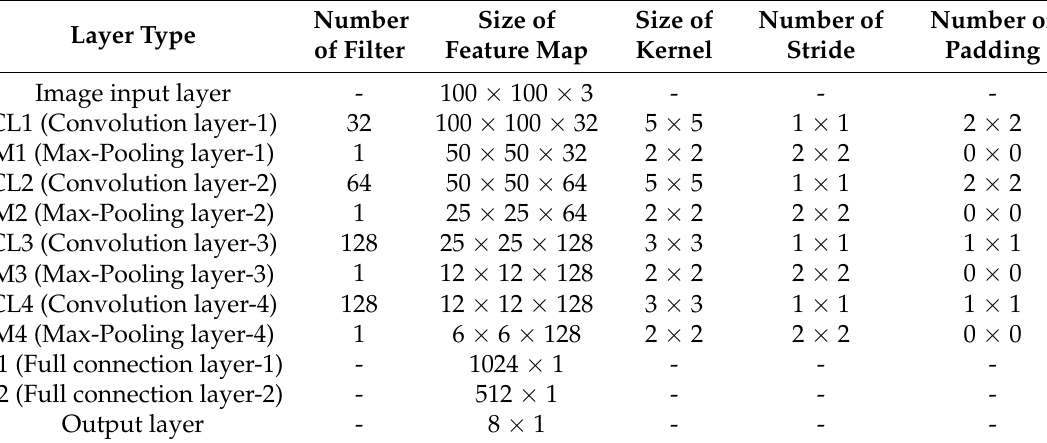
Figure 7. Thermal images under eight gears with different health conditions: ( a ) healthy condition ( b ) pitting in the driving tooth ( c ) a broken tooth in the driving gear ( d ) a missing tooth in the driving gear ( e ) crack in the follower tooth ( f ) pitting in the driving gear with crack in the follower tooth pitting teeth ( g ) broken tooth in the driving gear with crack in the follower tooth ( h ) missing tooth in the driving tooth with crack in the follower tooth. Table 3. The detailed structure of